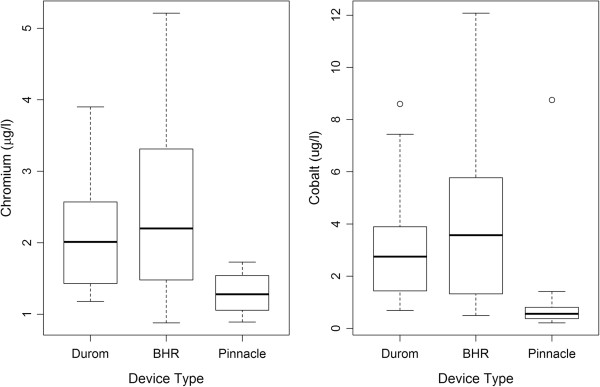
Box and whisker plots showing the distributions of chromium and cobalt levels for all patients by implant type. For each device type, the top and bottom of the ‘box’ represents the 75th and 25th percentiles of the data. The heavy horizontal line through the box is the median. Circles outside of the ‘whiskers’ represent outliers. The top and bottom of the whiskers are the maximum and minimum values that are not outliers.